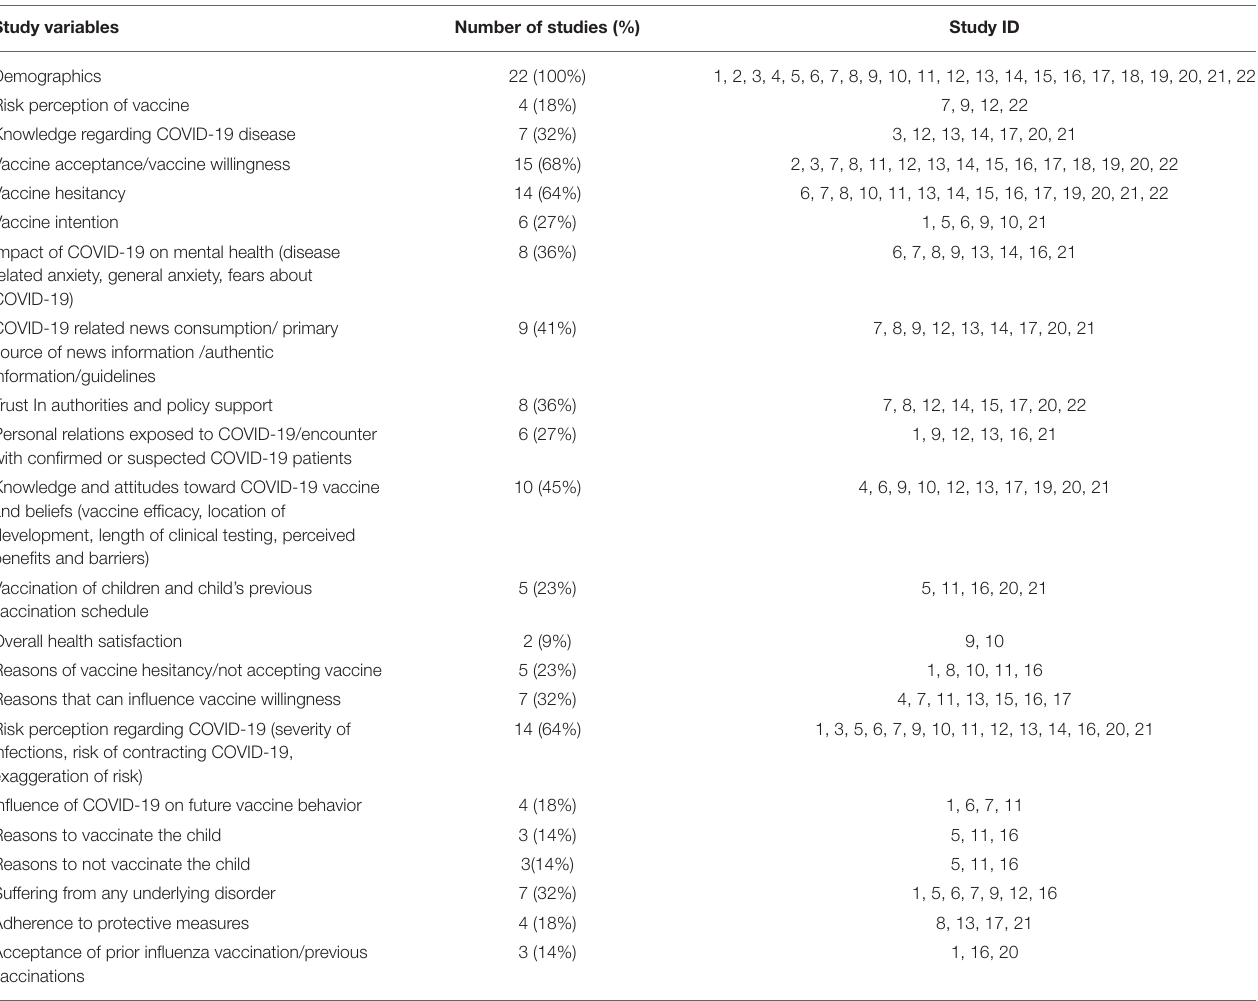
TABLE 2 | Variables examined in included COVID-19 surveys